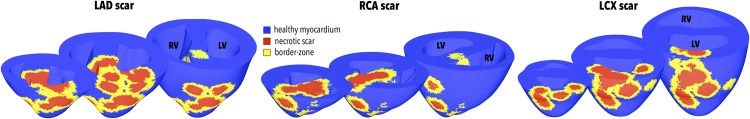
Three different anatomically-based representations of infarct scar and BZ within the rabbit ventricular model based on infarct formation following occlusion of the LAD, RCA and LCX.Healthy ventricular tissue is shown in blue with necrotic scar in red and BZ tissue in yellow. For each individual scar anatomy, three separate short-axis clipping plane views (near the apex, mid- and base) have been used to highlight intramural scar anatomy.